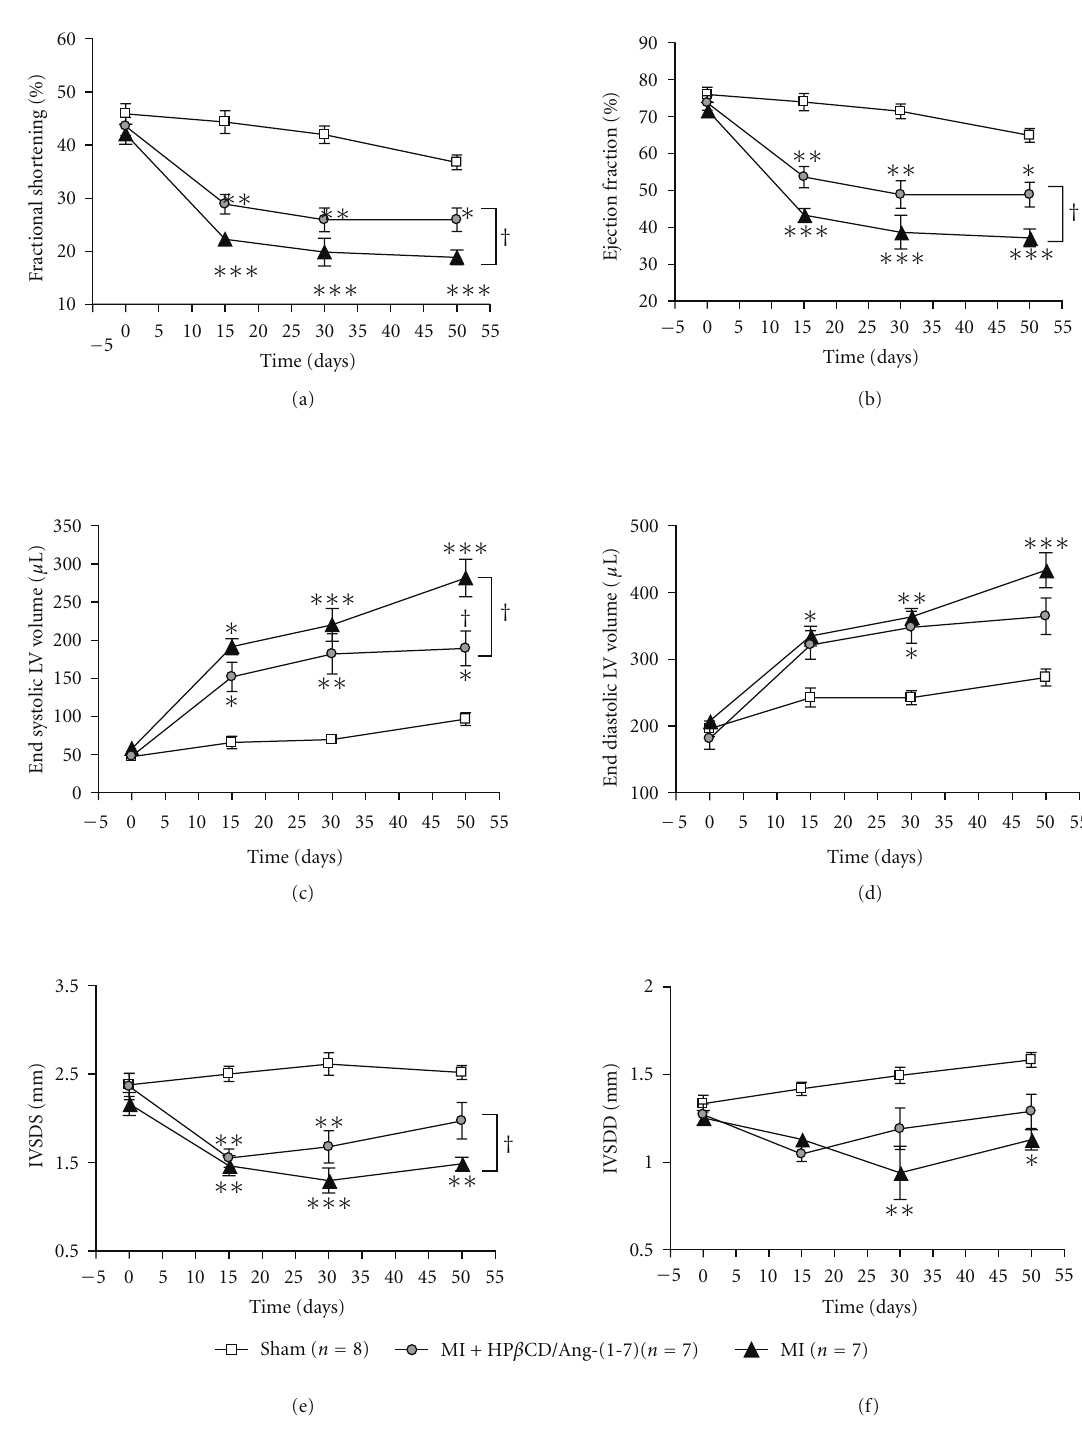
Figure 1: E ff ects of HP β CD/Ang-(1–7) on echocardiographic parameters after left coronary artery ligation in rats followed for up to 50 days. (a) Fractional shortening, (b) ejection fraction, (c) end systolic left ventricular volume, (d) end diastolic left ventricular volume, (e) interventricular septal dimension in systole, and (f) interventricular septal dimension in diastole. ∗ P < 0 . 05 versus sham; ∗∗ P < 0 . 01 versus sham; ∗∗∗ P < 0 . 001 versus sham; † P < 0 . 05 versus MI (two-way ANOVA followed by the Bonferroni